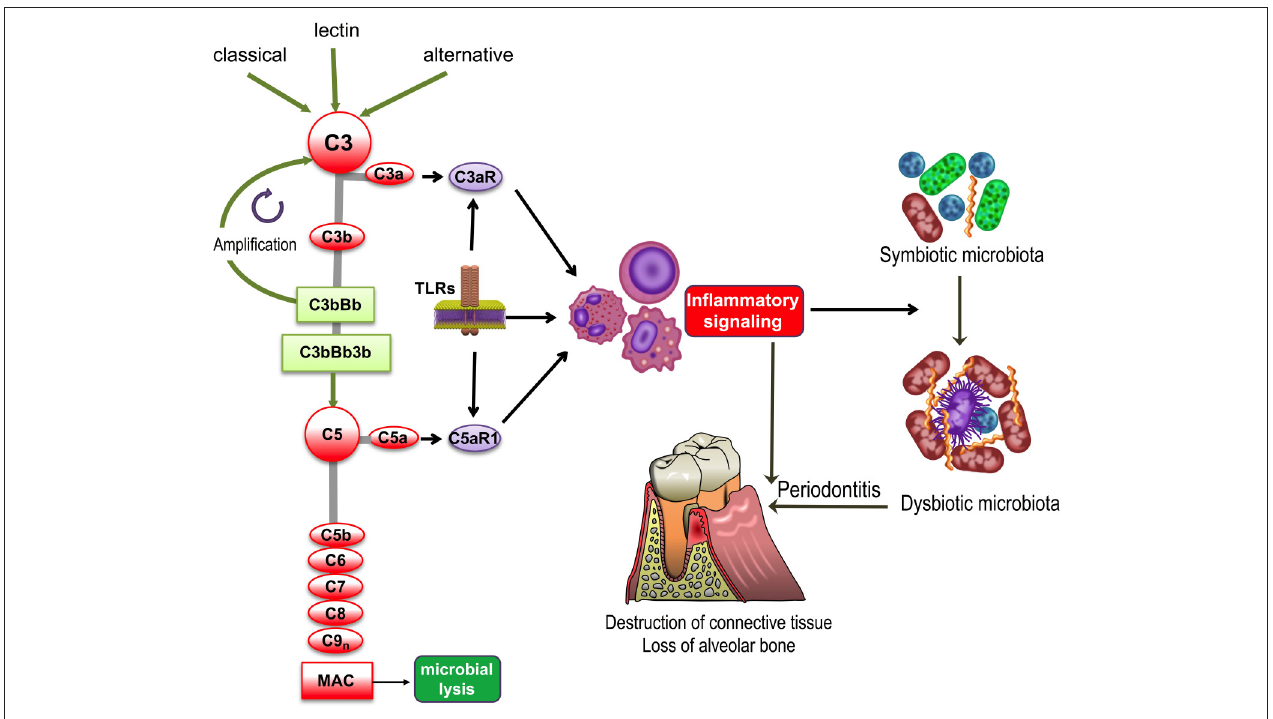
FIGURE 1 | Complement and TLR involvement in dysbiosis and inflammatory bone loss in periodontitis. The classic, lectin, and alternative pathways converge at and activate the central complement component, C3, resulting in the generation of various effectors, such as, the C3b opsonin, the inflammatory anaphylatoxins C3a and C5a, and the C5b-9 membrane attack complex (MAC). The C3a and C5a activation fragments activate respectively C3aR and C5aR1, which cross-talk with Toll-like receptors (TLRs) and synergistically activate inflammatory leukocytes. TLRs also upregulate the expression of C3aR and C5aR1. Inflammation induced by complement-TLR crosstalk interactions not only causes gingival tissue destruction and bone loss in periodontitis but also contributes to the remodeling of a symbiotic microbiota into a dysbiotic one, thereby further potentiating destructive